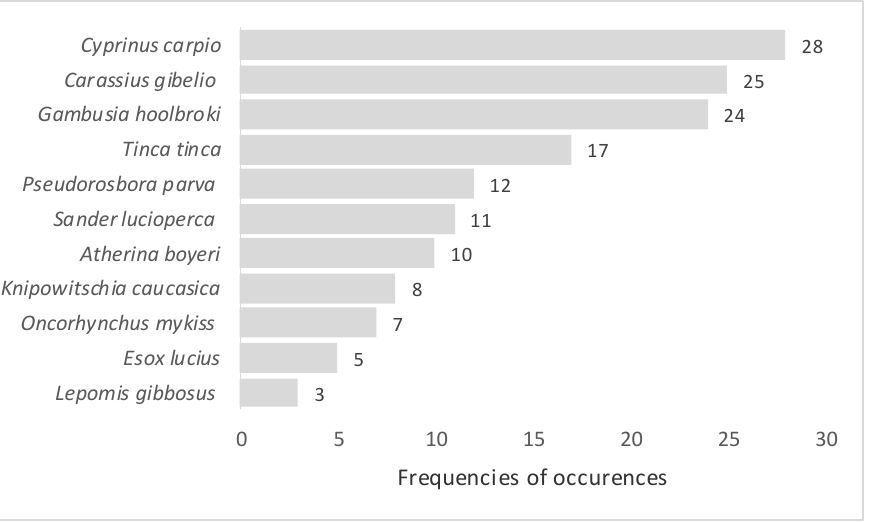
Figure 7. Frequencies of occurrence of the main non-native and translocated species in the examined Turkish lakes.